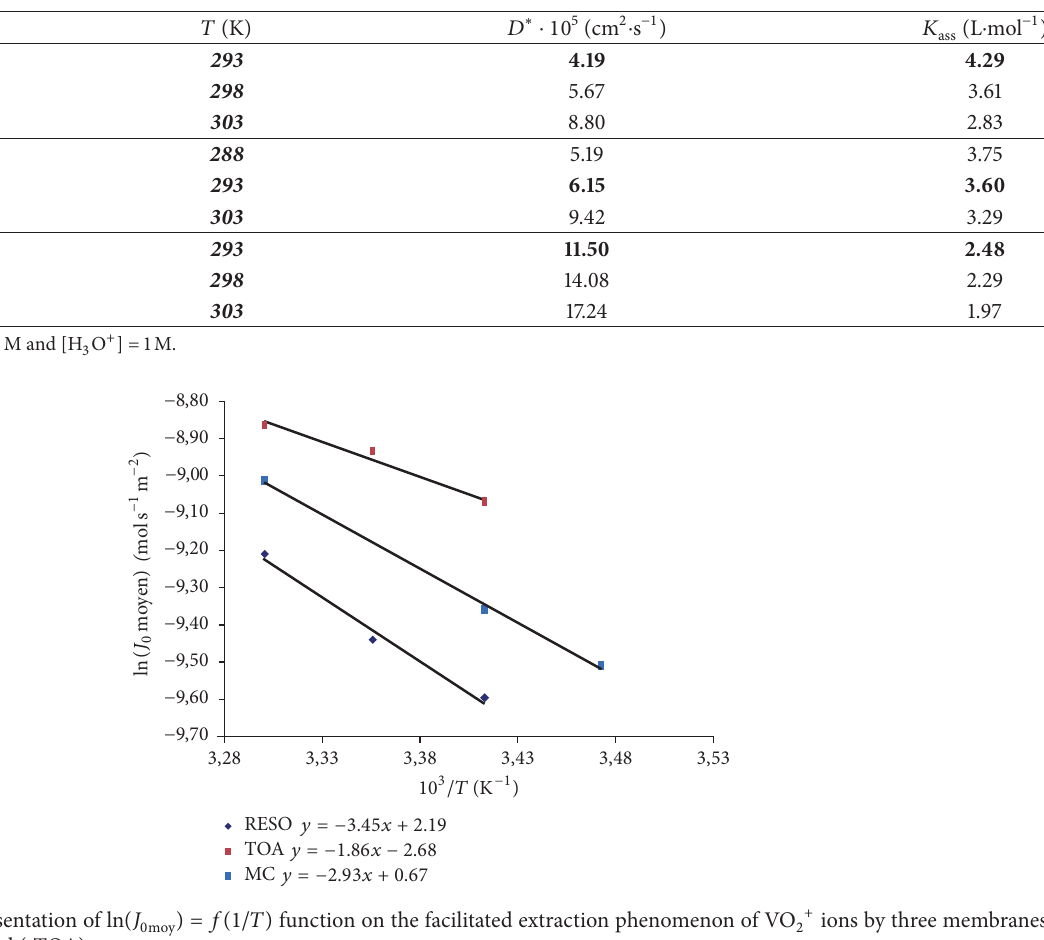
and 𝐷 ∗ for the facilitated extraction phenomenon of VO 2+ ions. ass